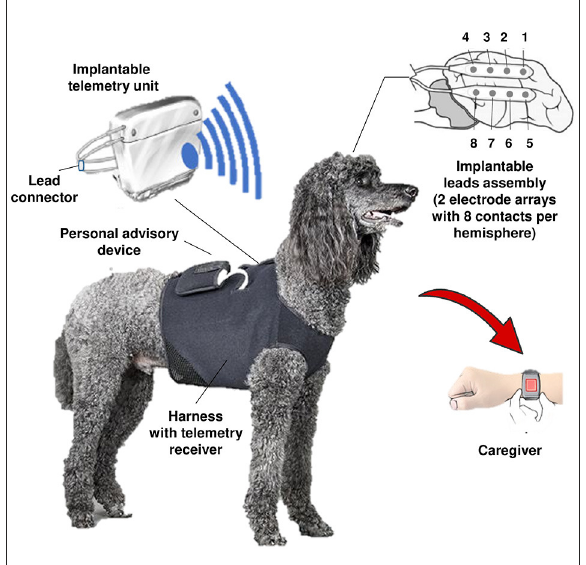
FIGURE5 Schematic of a dog with an implanted ambulatory NeuroVista Seizure Advisory System (SAS). The implantable device for recording and storing continuous iEEG includes: An Implantable Lead Assembly (ILA) placed in the subdural space, an Implantable Telemetry Unit (ITU), and a Personal Advisory Device (PAD). The ILA, which acquires 16 channels of iEEG, detects and relays electrical activity in the brain to the ITU. The ITU receives data from the implantable leads, predicts seizure activity using an algorithm, and sends a wireless alert to the PAD. The PAD sends a wireless alert to the caregiver, which may lead to accelerated intervention and administration of seizure-stopping medication (see text). All iEEG data are stored on a flash drive and uploaded weekly via the internet to a central data storage site. Modified from Coles et al.